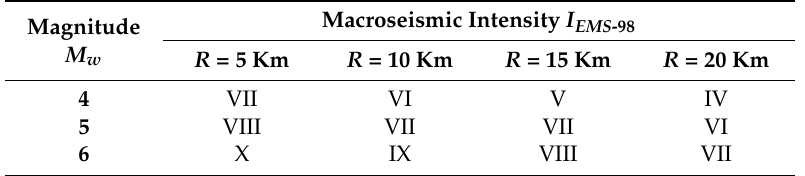
Table 2. The correlation between the moment magnitude, M w , and macroseismic intensity, I EMS -98 .